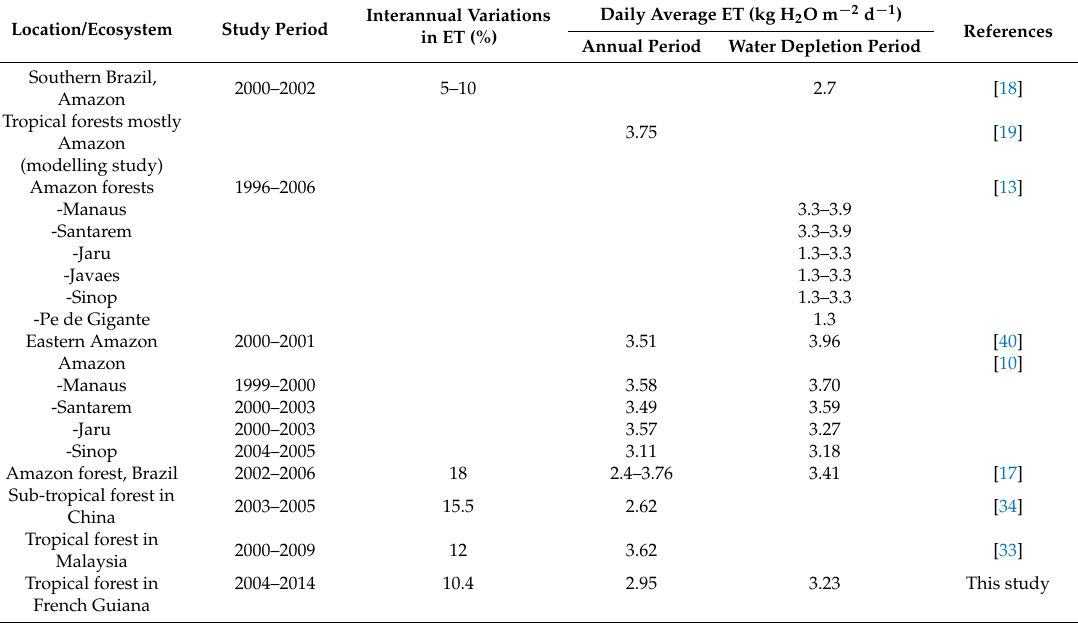
Table 3. Comparison of evapotranspiration (ET) in various studies from the Amazon and other tropical